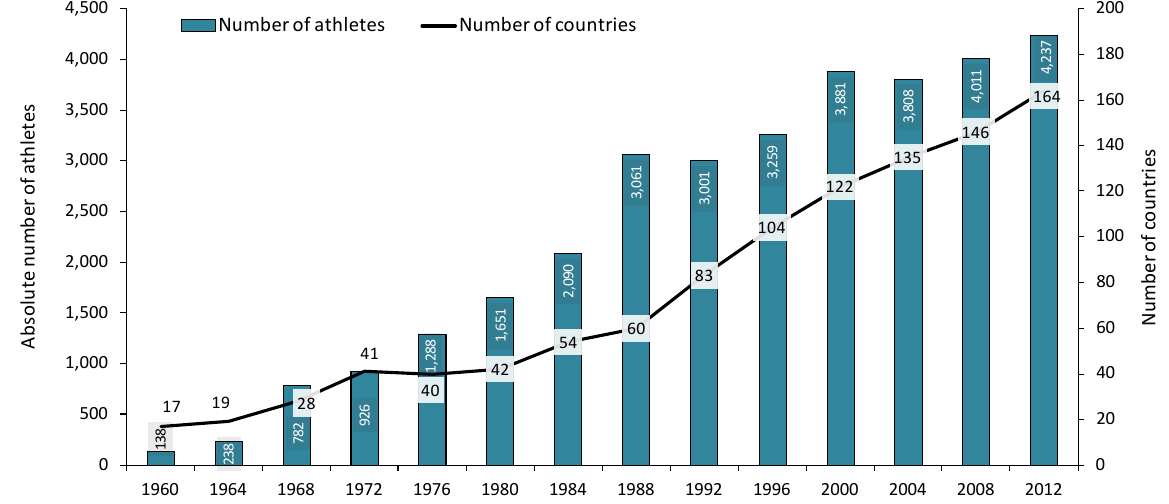
Figure 1. Global participation (athletes and countries) in the Paralympic Games, from 1960 until 2012 9